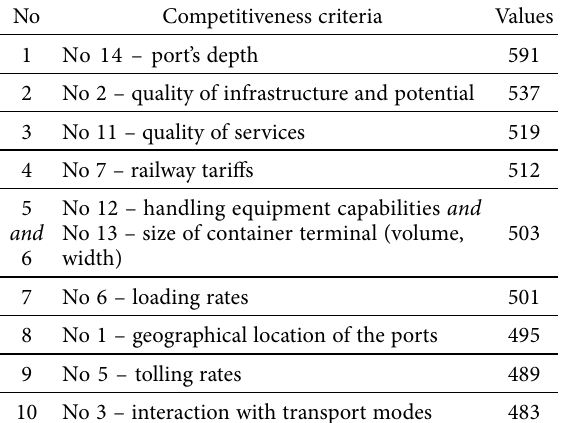
Table 1. Setting the criteria, indicates